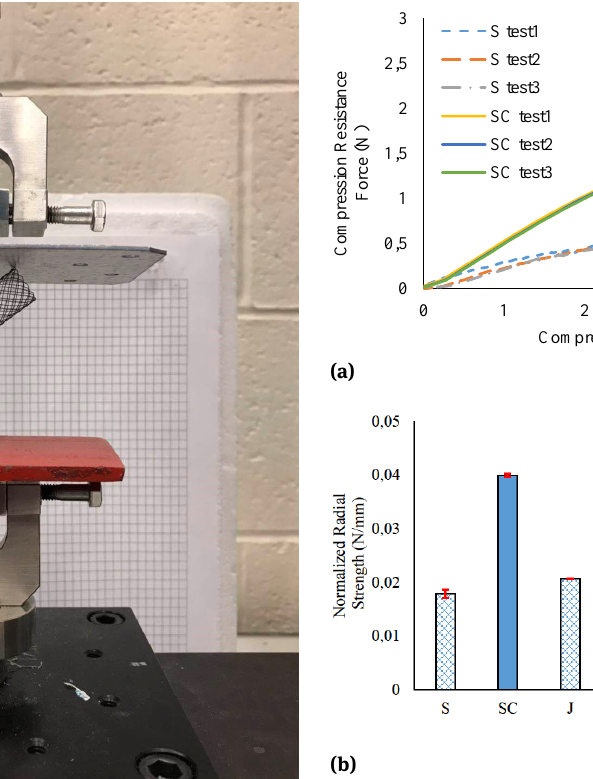
Figure 3: Bending test of the branches for both J-shaped and Y- shaped stents.